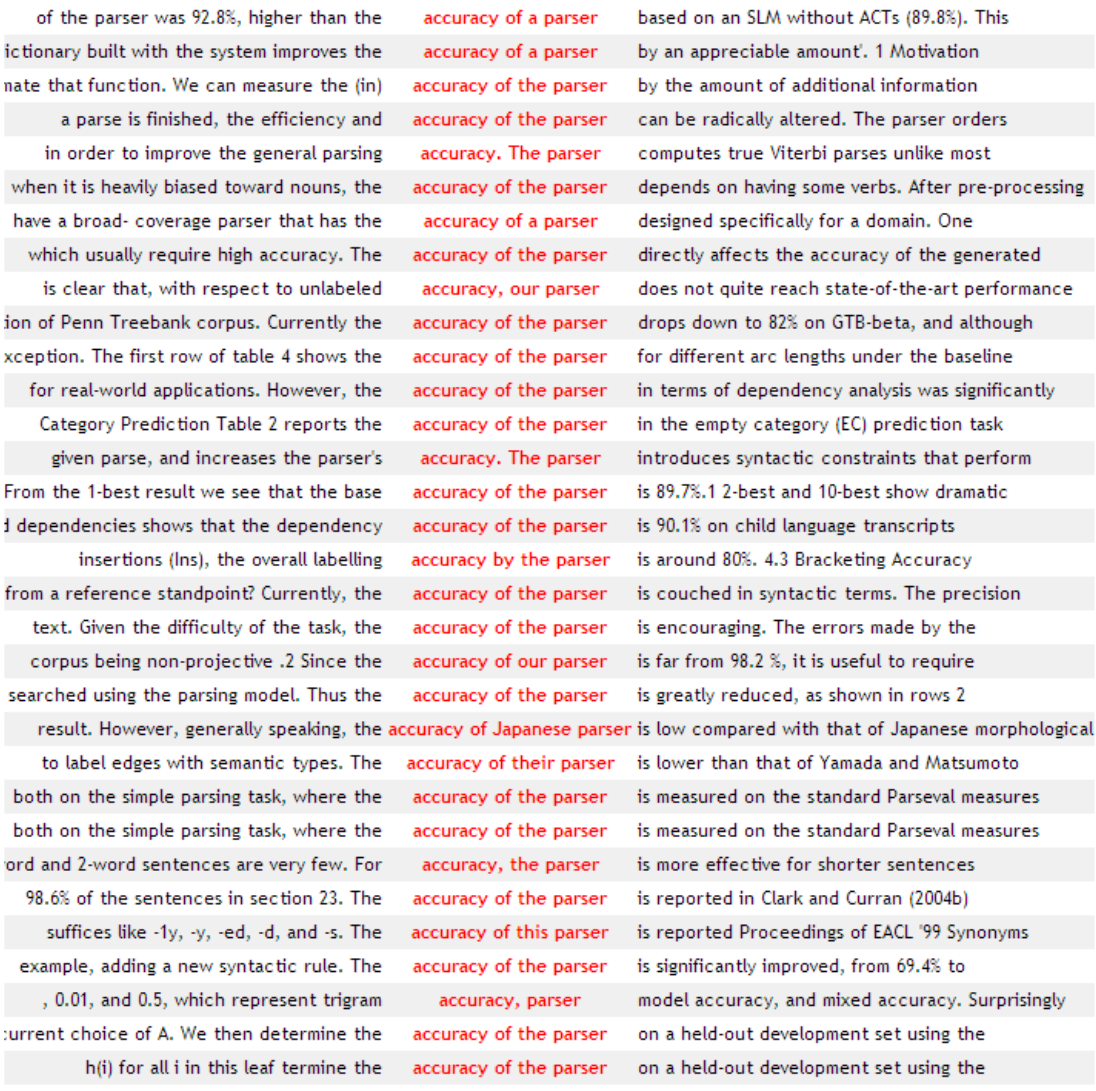
Figure 5: Sample concordance showing results of CQL results for “accuracy” []{0,2} “parser” in the ACL corpus/Sketch